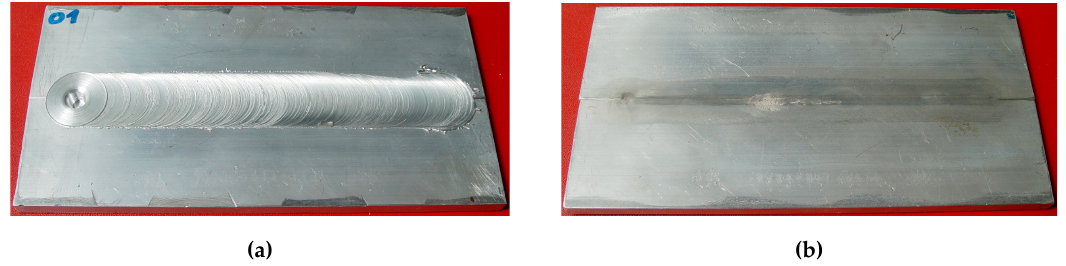
Figure 3. The welded joint in the 1st point of the experimental plan. ( a ) a view from the top; ( b ) a bottom view.